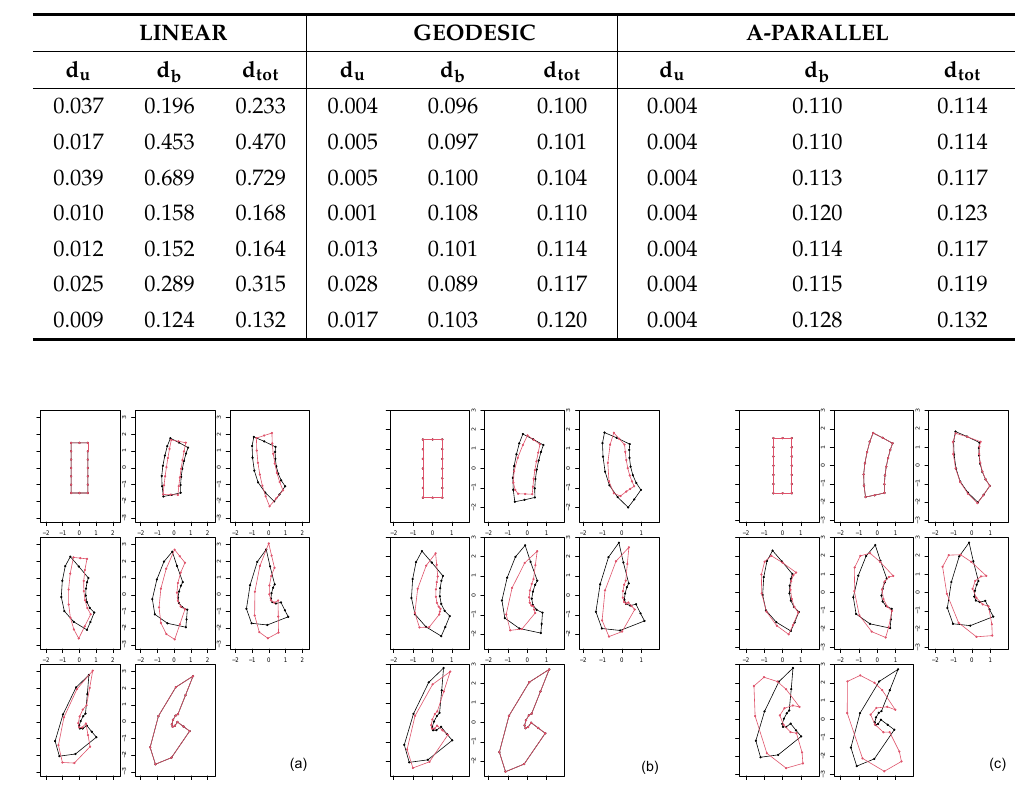
Table 5. Values of the energies for the non-affine case of bending and general affine deformation; d u represents the affine component of the Γ -energy, d b the non-affine component, and d tot the total Γ -energy.